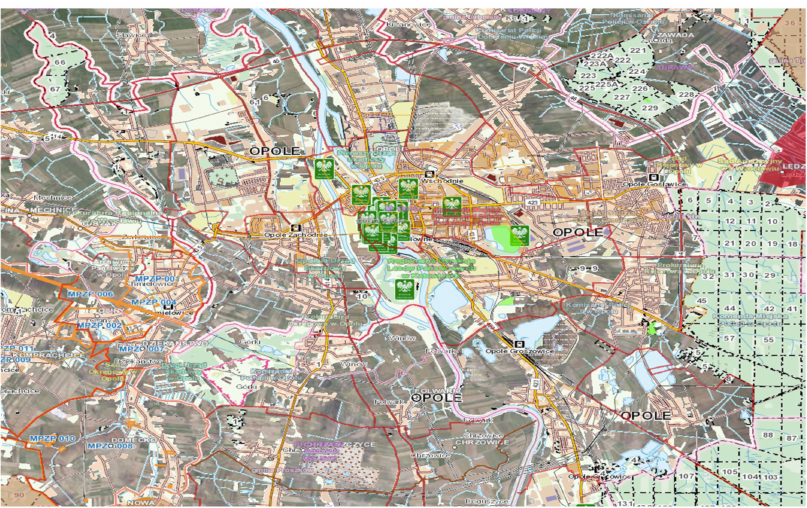
Figure 6. Stage 4—Identifying the closest locations of Traffic Shaping Facilities in the